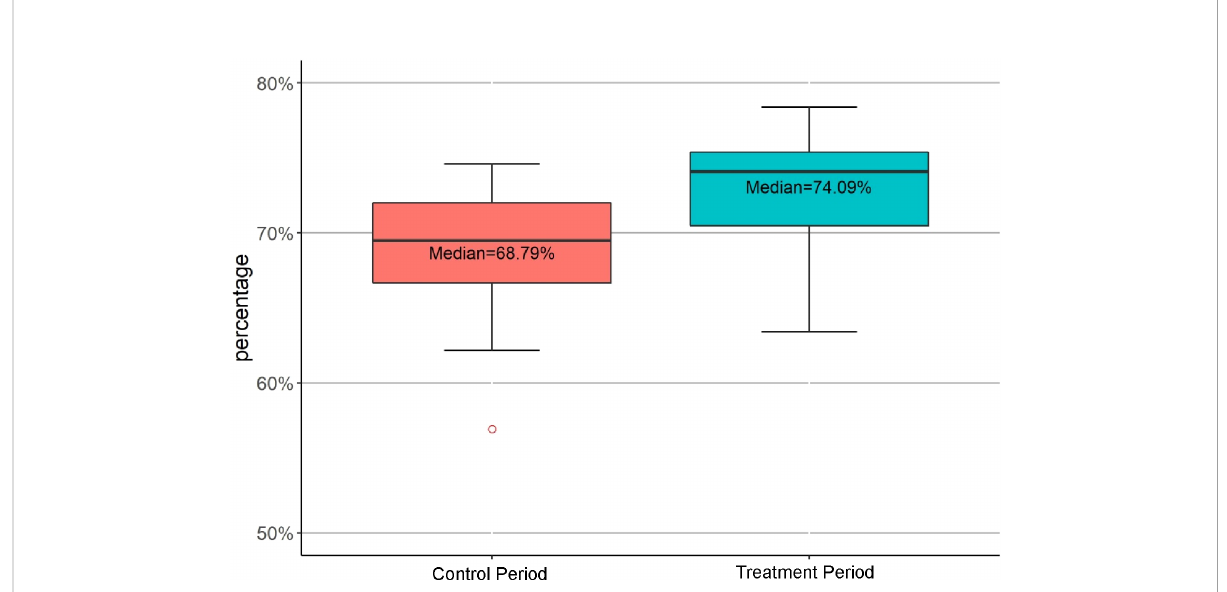
FIGURE 3 Comparison of the Fractions of Weekly Performed Lung Cancer Surgery in the Control and Treatment Periods. Percentages were the mean fractions of lung cancer surgery performed weekly. The mean fraction of lung cancer surgery in the treatment period was signi fi cantly greater than that of the control period (p=0.007).